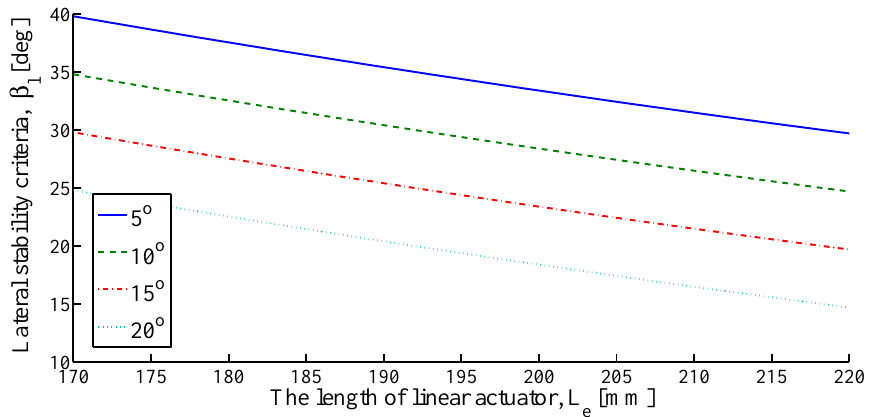
Figure 10. Inputs on mobile robot stability responses.